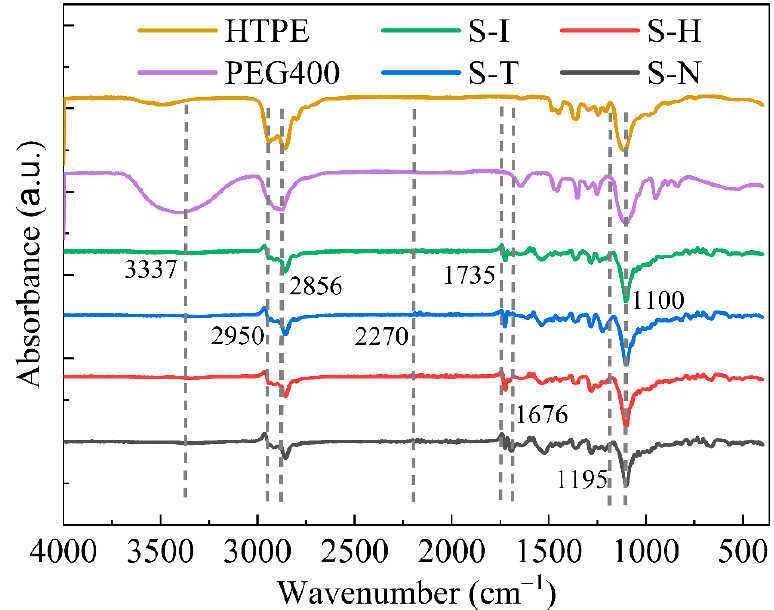
Figure 10. ATR/FTIR spectra of HTPE four HTPE/PEG interpenetrating polymer network binders.